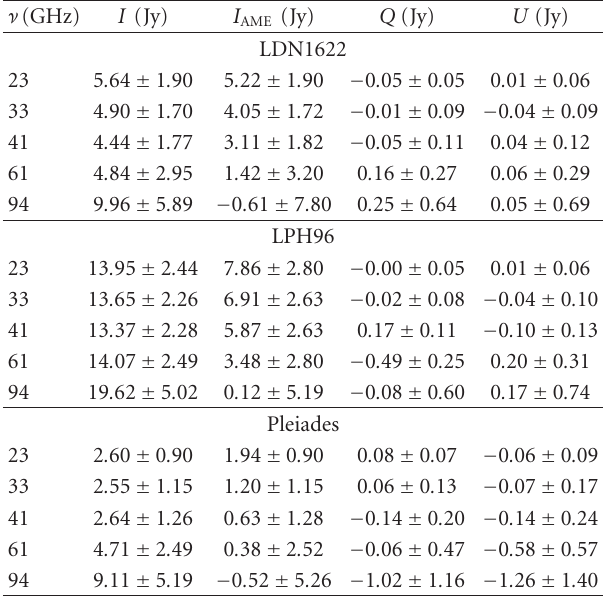
Table 3: Stokes I , Q , and U measured in LDN1622, LPH96, and the Pleiades.